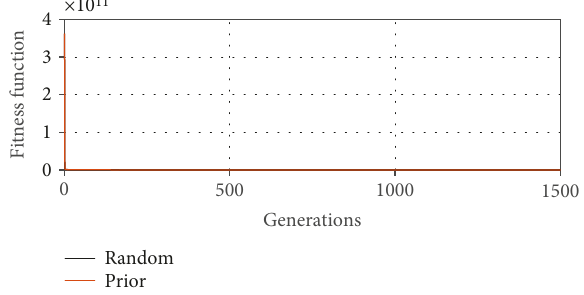
Figure 14: Evolution of the fi tness function of strategy 7 through generations. Table 23: Summary of results for all experiments over case study 2: 10-year period G&TEP